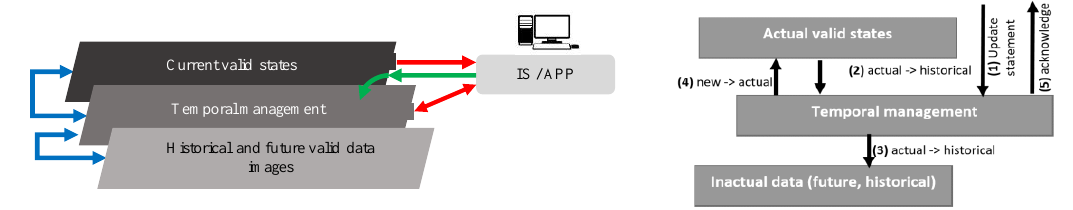
Figure 5. Attribute oriented temporal model.